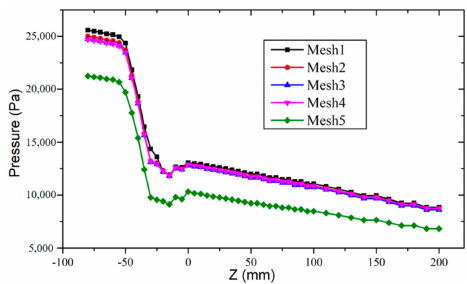
Figure 6. Distribution of the pressure for di ff erent meshes.